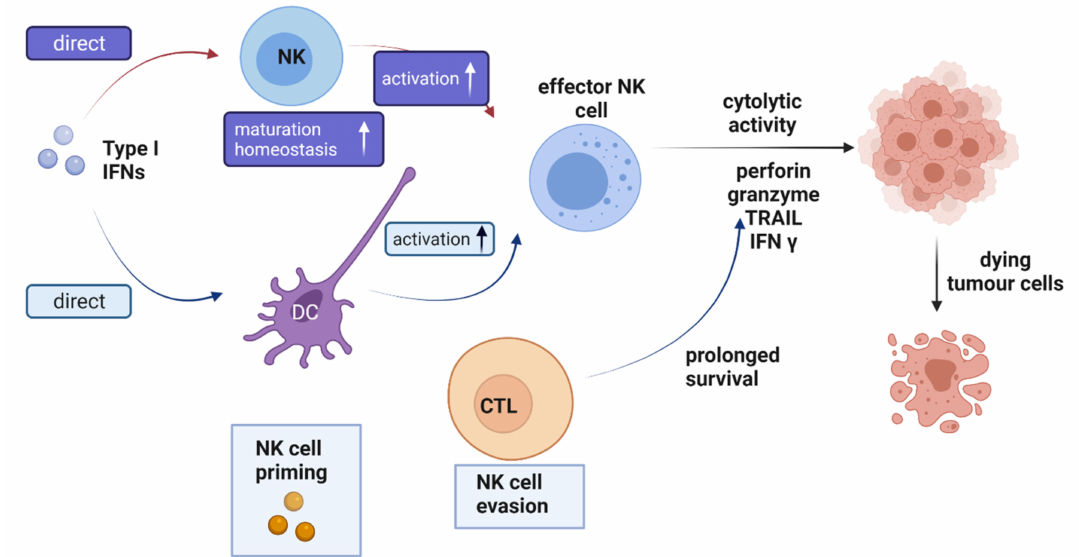
Figure 5. Activation pathways are regulated by type I interferons (IFNs) in the antitumor response. The antiproliferative activity of type I IFNs has anti-angiogenic effects on tumor vascularization, increased cytotoxicity, and survival of NK cells. These cytokines induce the generation and survival of cytotoxic T lymphocytes, memory CD8 T, and maturation of dendritic cells. Type I IFNs influence the maturation, homeostasis, and activation of NK cells, eliminating tumor cells through other immune cells or cells of the tumor microenvironment. Dendritic cells play an essential role in recognizing and presenting the various antigens that trigger the activation cascade. Another indirect effect of type I IFNs on NK cells in a tumor environment is the modulation of surface molecules on CD8 + cytotoxic T lymphocytes (CTL) [NCR1 ligands; classical and non-classical major histocompatibility complex class I (MHC I)] with evasion of CTLs from NK cell-mediated killing. Created with BioRender.com.